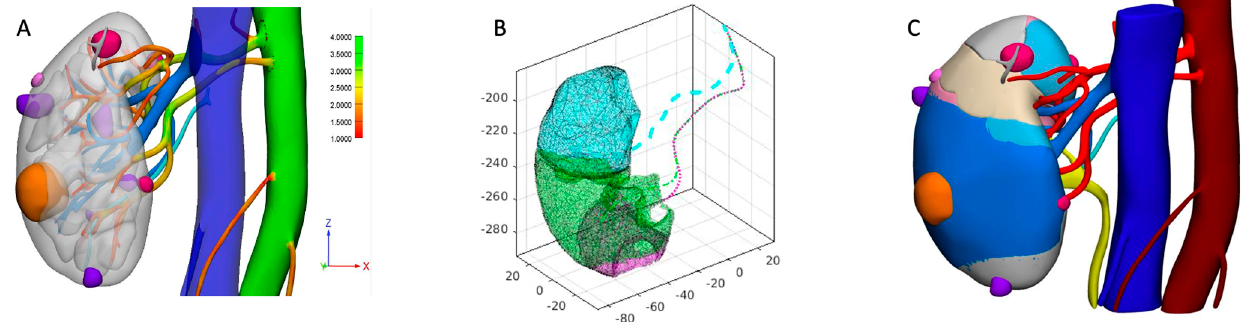
Figure 1. Description of perfusion 3DVM building process. ( A ) A standard 3DVM is built, and vessels of interest are identified. ( B ) For each portion of parenchyma, the closest distance from each artery is calculated, and perfusion regions are automatically built. ( C ) Finally, the 3D virtual perfusion model is refined and finalized as a 3D navigable PDF, allowing the surgeon to appreciate the different perfusion regions of the organ, the tumor (orange), and cyst (purple and violet) locations.